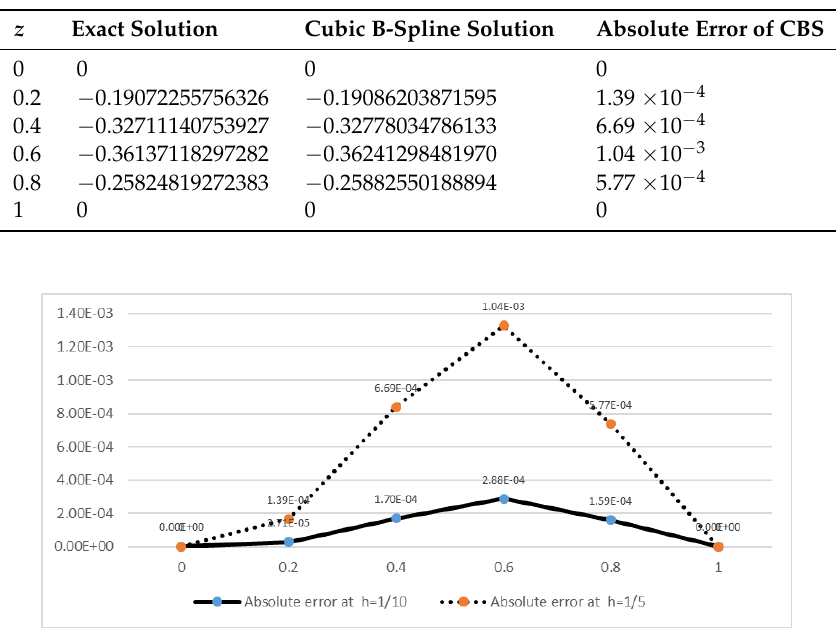
Figure 3. Graphical comparison of Problem 3 at h = 1